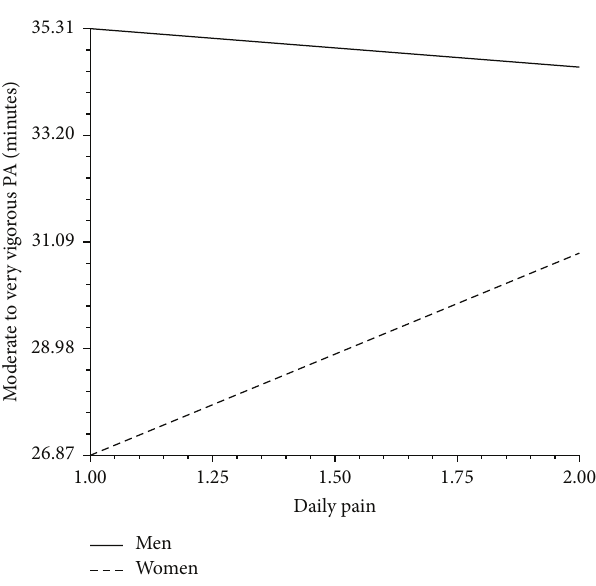
Figure1:Minutesofmoderatetoveryvigorousactivityasafunction of daily pain and